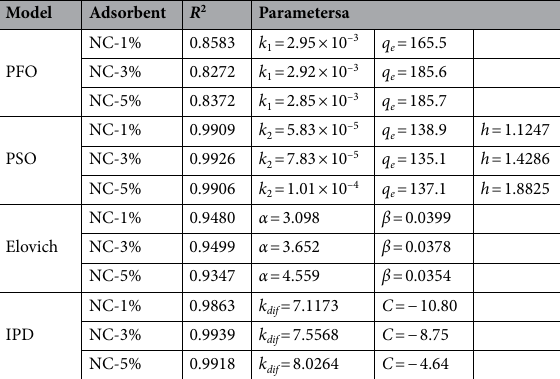
Table 2. The kinetic parameters for the adsorption of Congo red onto the prepared nanocomposites. a The units are mentioned in “The kinetic